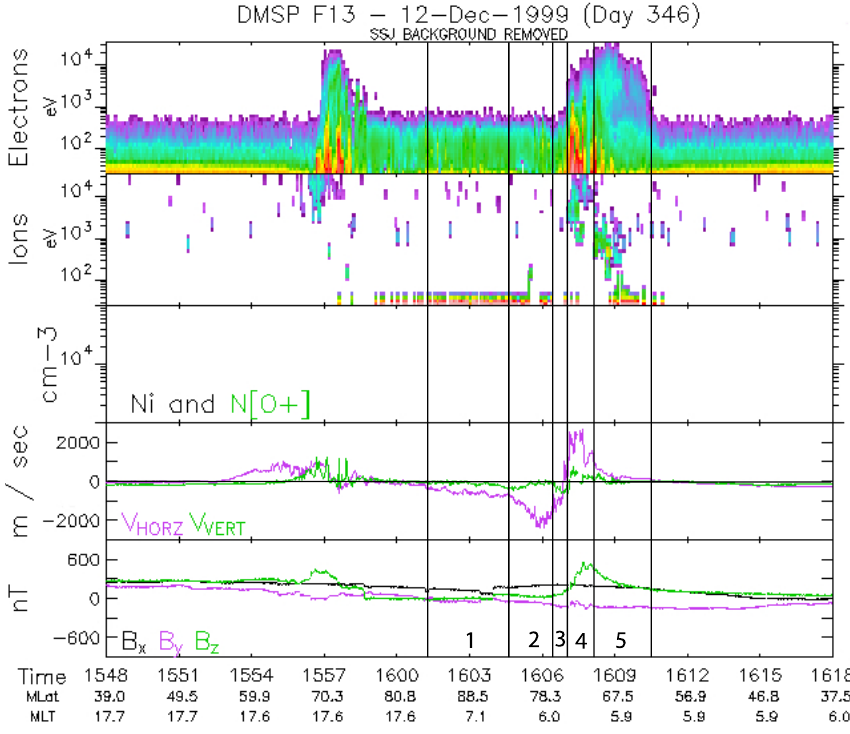
Fig. 17. Northern Hemisphere DMSP F13 data for the interval 15:48–16:18UT. Precipitation/Birkeland current/convection regimes marked 1–5 are: (1): P.RAIN (central polar cap); (2): P.RAIN, C1 current and flow channel FC 2; (3): P.RAIN/LLBL and C2 current; (4): BPS and R1 current; (5): CPS and R2 current. Event category: NH-dawn/ B y > 0